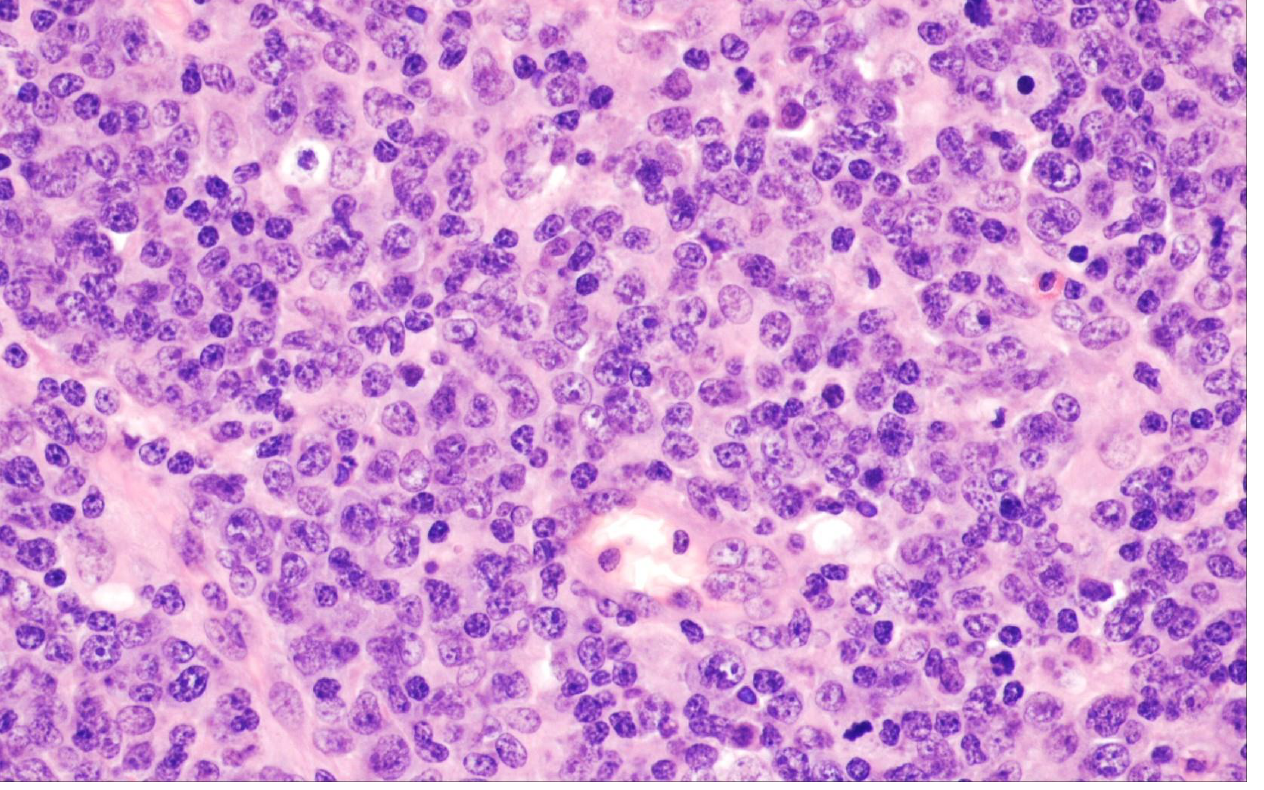
Figure 3. Diffuse large B-cell-lymphoma/High-grade-B-cell-lymphoma with MYC and BCL2 rear- rangements (H&E × 400). This tumor has a DLBCL morphology. Upon FISH, it showed a “triple hit” constellation with MYC, BCL2 , and BCL6 rearrangements.